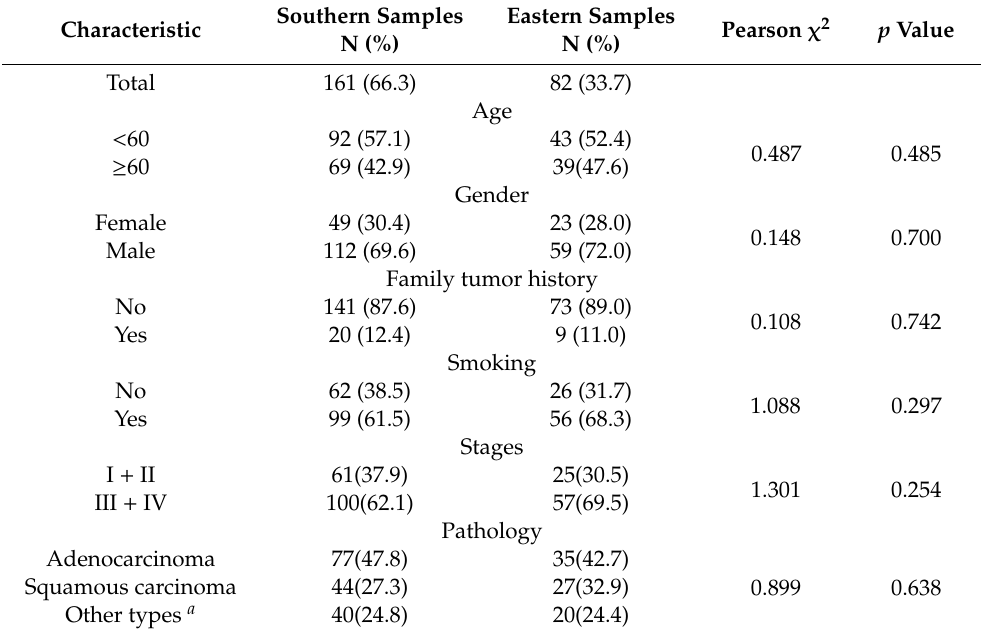
Table 2. Demographics and clinical features of studied